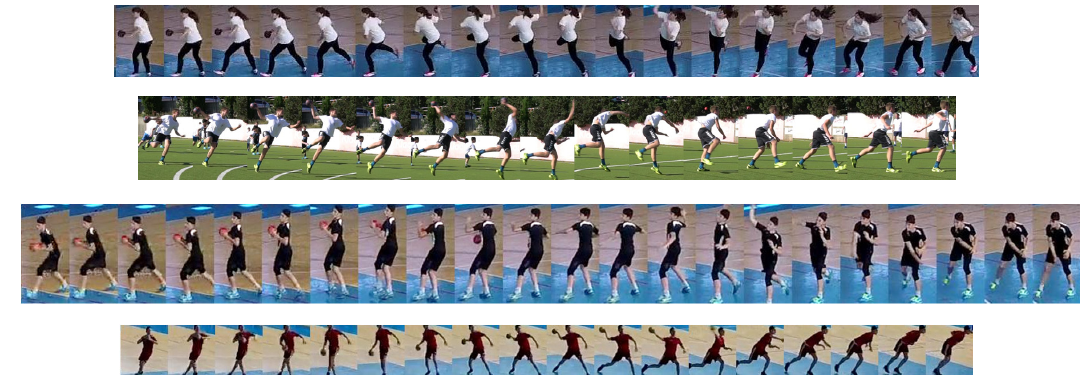
Figure 17. Examples of shooting action with and without jump performed by different players in different positions with respect to the camera in both outdoor and indoor fields.